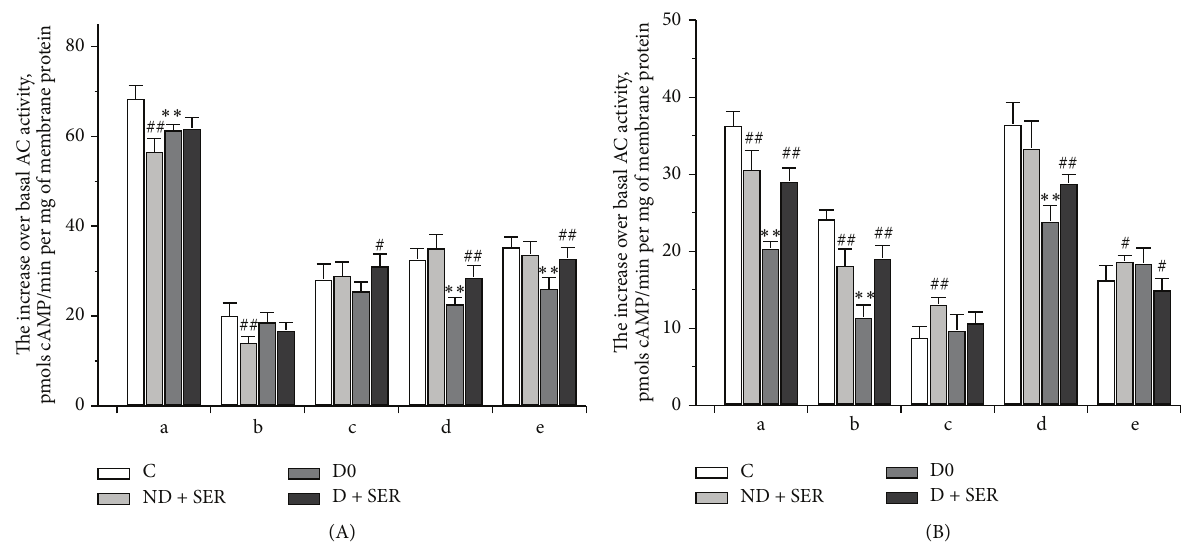
Figure 5: The AC stimulating effects of agonists of monoaminergic (a) and peptidergic (b) receptors in the brain of diabetic and nondiabetic rats and the influence of IS treatment. (A): a—serotonin, b—EMD-386088, c—dopamine, d—norepinephrine, and e—isoproterenol (all were used at a concentration of 10 −5 M); (B): a— 𝛼 -MSH (10 −7 M), b—THIQ (10 −7 M), c— 𝛾 -MSH (10 −7 M), d—relaxin (10 −8 M), and e—PACAP- 38 (10 −6 M). The AC stimulating effect was expressed as hormone-induced increase of AC activity over the basal enzyme activity, pmol cAMP/min per mg of membrane protein. The data are presented as M ± SD. ( ∗∗ ) The difference between Groups C0 and D0 is significant at 𝑃 < 0 . 0001, and (#, ##) the differences between Groups C0 and ND + SER or between Groups D0 and D + SER are significant at 𝑃 < 0 . 05 and 𝑃 < 0 . 0001, respectively.